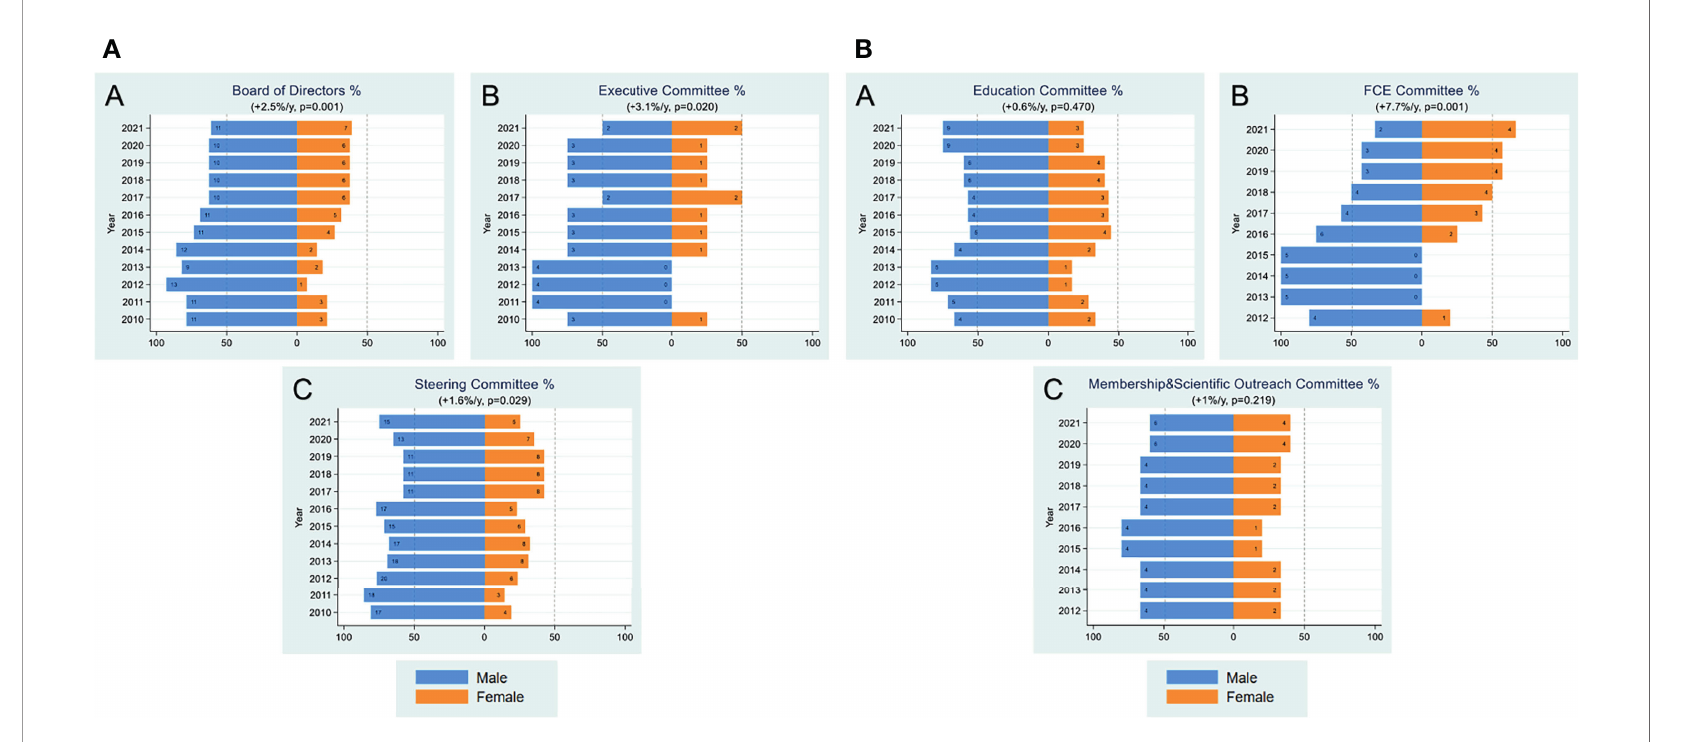
FIGURE 6 | (A) Leadership. Yearly female percentages in board of directors (A), executive committee (B) and steering committee (C) are shown over the period 2010-2021. Percentages were based on actual numbers subjects stating their gender. Average changes per year and p-values (shown in parentheses) were estimated by the slope coef fi cient from a simple linear regression model. The dotted line represents 50% as a point of reference for parity. (B) Leadership. Yearly female percentages in education committee (A) , FCE committee (B) , membership & scienti fi c outreach committee (C) are shown over the period 2010-2021. Percentages were based on actual numbers subjects stating their gender. Average changes per year and p-values (shown in parentheses) were estimated by the slope coef fi cient from a simple linear regression model. Gender data for FCE and membership & scienti fi c outreach committees were not collected until 2012. The dotted line represents 50% as a point of reference for